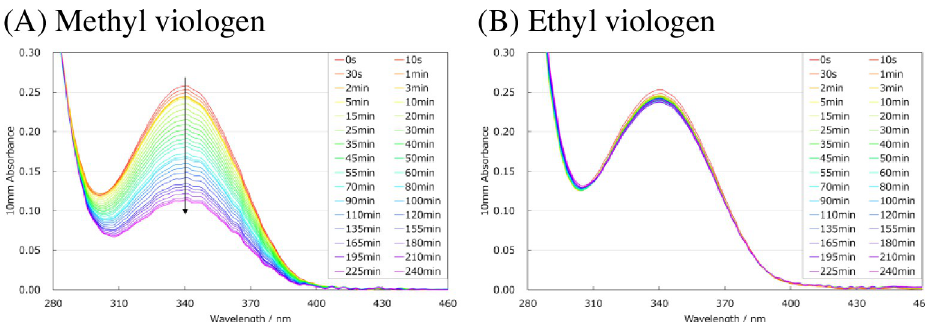
Fig 5. Absorbance change of mixed solution of electronic mediator and NADPH. (A) Methyl viologen, (B) Ethyl viologen, (C) 4,4 0 -Dipyridyl. These experiments were repeated three times with similar results.